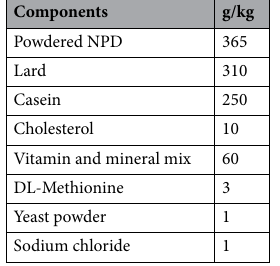
Table 1. Components of high fat